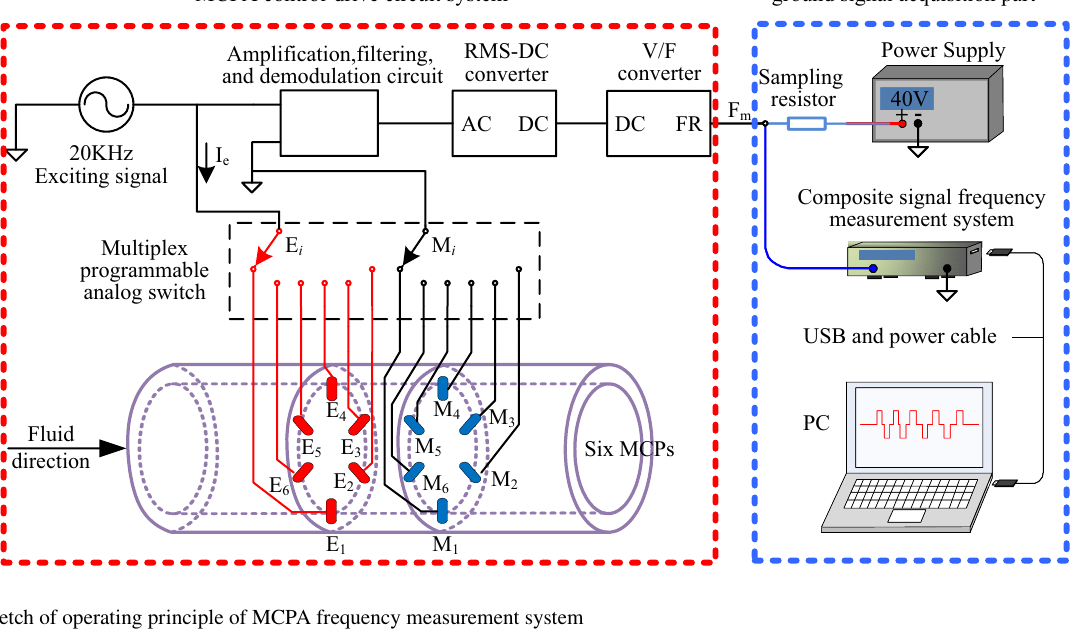
Fig. 9 Sketch of operating principle of MCPA frequency measurement system